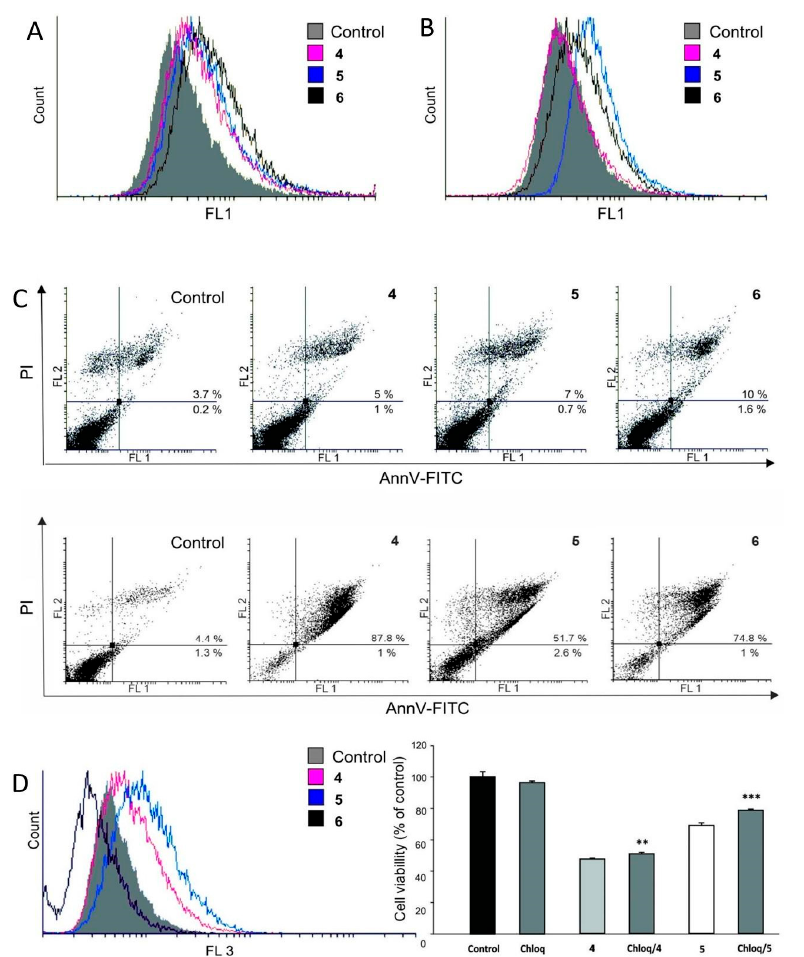
Figure 4. Tamoxifen derivatives attenuated MCF-7 cell division and induced programmed cell death type 1 and 2. MCF-7 cells were exposed to IC 50 doses of compounds 4 , 5 and 6 for 60 or 72 h and analysed by flow cytometry: ( A ) cell proliferation rate, fluorescence intensity from FL1 channel (exc. 488 nm/em. 536 nm); ( B ) ApoStat staining for caspase-dependent apoptosis, fluorescence intensity from FL1 channel; ( C ) apoptosis detection (AnnV-FITC/PI staining) after 60 h (upper panels) or 72 h (lower panels), fluorescence intensity from FL2 channel (y axis, exc. 488 nm/em. 590 nm) vs. FL1 channel (x axis); ( D ) autophagy detection after 60 h and determination of the role of autophagy by specific inhibitor chloroquine (Chloq) (20 µ M), fluorescence intensity from FL3 channel (exc. 488 nm/em. 675 nm). The data are presented as mean ± SD of triplicate cultures (** p < 0.01; *** p < 0.001 refers to compound-treated cultures. Representative dot plots and histograms are shown from at least three independent experiments).